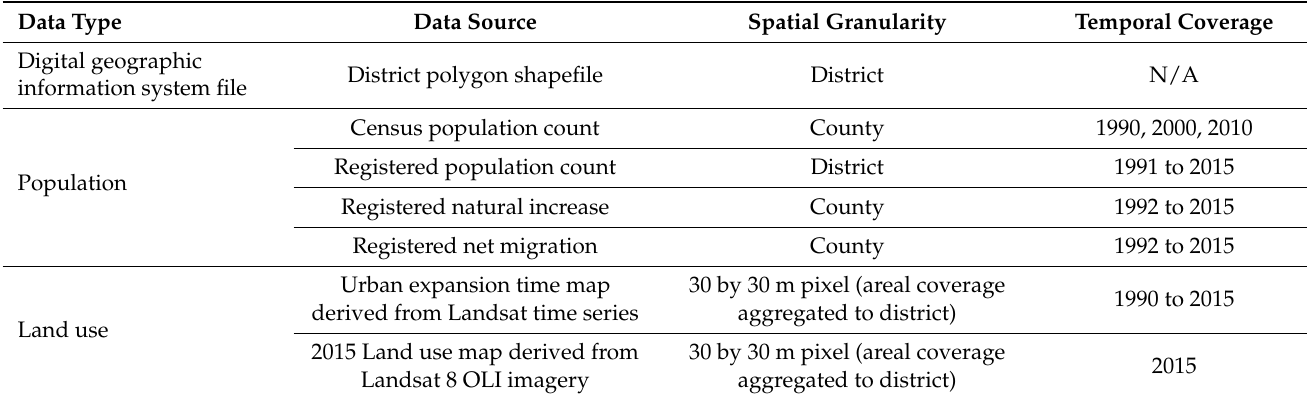
Table 1. Data Table 1. Data summary.